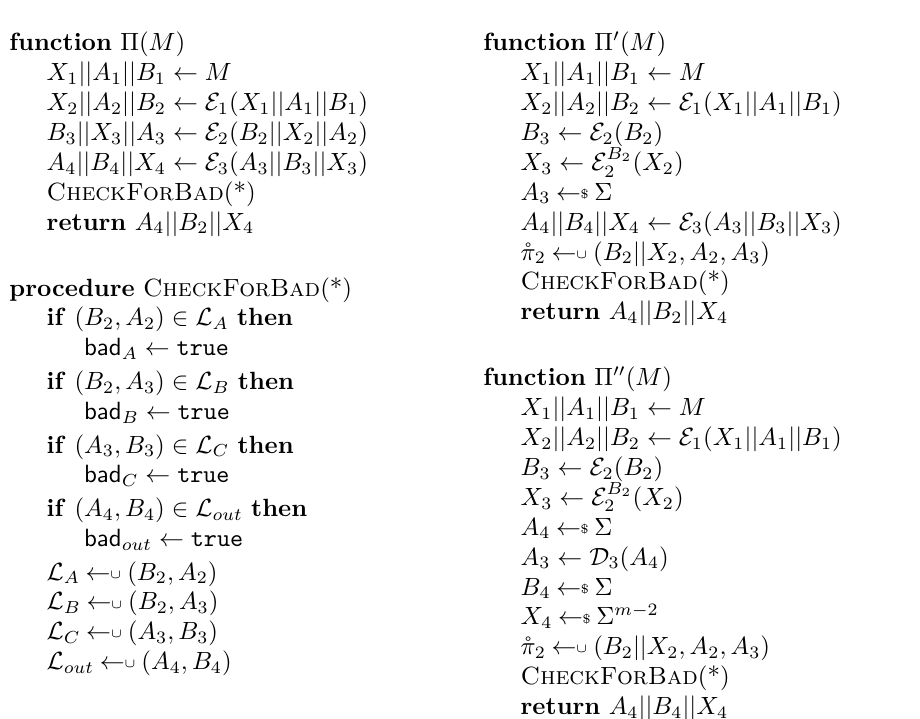
Π is the code for the original scheme, with the online permutation calls separated and the blocks reordered according to right . Moving from Π to Π 0 corresponds to expanding out the second permutation call and substituting e E 2 in for E 2 . The switch from Π 0 to Π 00 is application of Lemma 6 to the line A 3 ← $ Σ and the call to E 3 . Overall, Π is identical to both Π 0 and Π 00 until procedure CheckForBad triggers bad